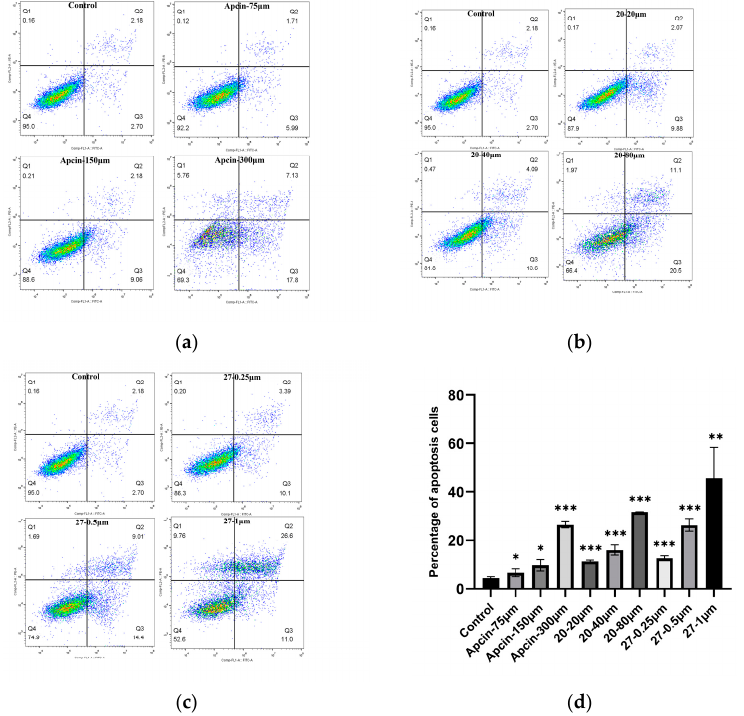
Figure 5. ( a – c ) Cells were treated with Apcin, compound 20, and compound 27 for 24 h. Cell lysate was analyzed to investigate the apoptotic cell. ( d ) Quantitative results are illustrated. Statistical significance was calculated by two-tailed unpaired t test (* P < 0.05, ** P < 0.01, *** P < 0.001, ****P < 0.0001)